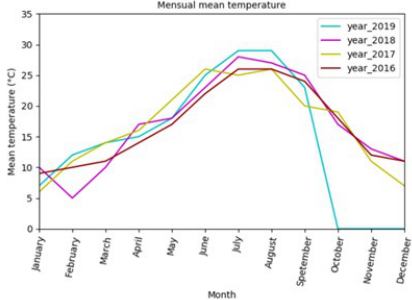
Figure 7. Temporal evolution of the average monthly temperature (in °C). Lowest temperature in winter 2018. The data are not available after October